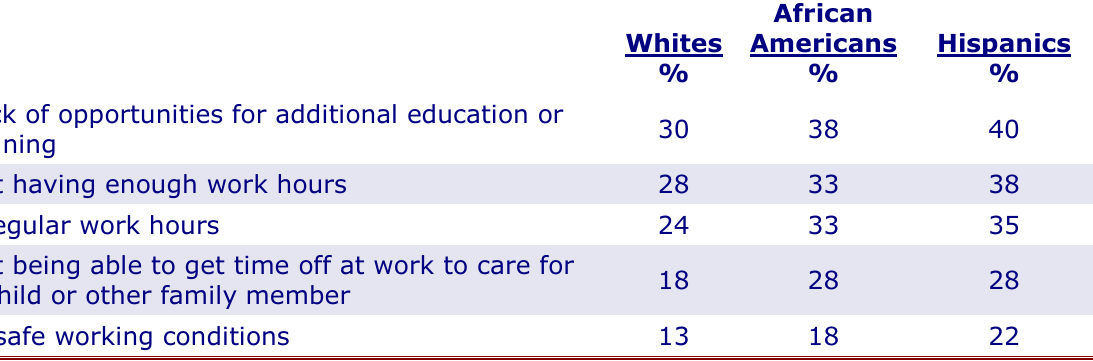
Table 7: Very or Fairly Big Problem Faced on the Job